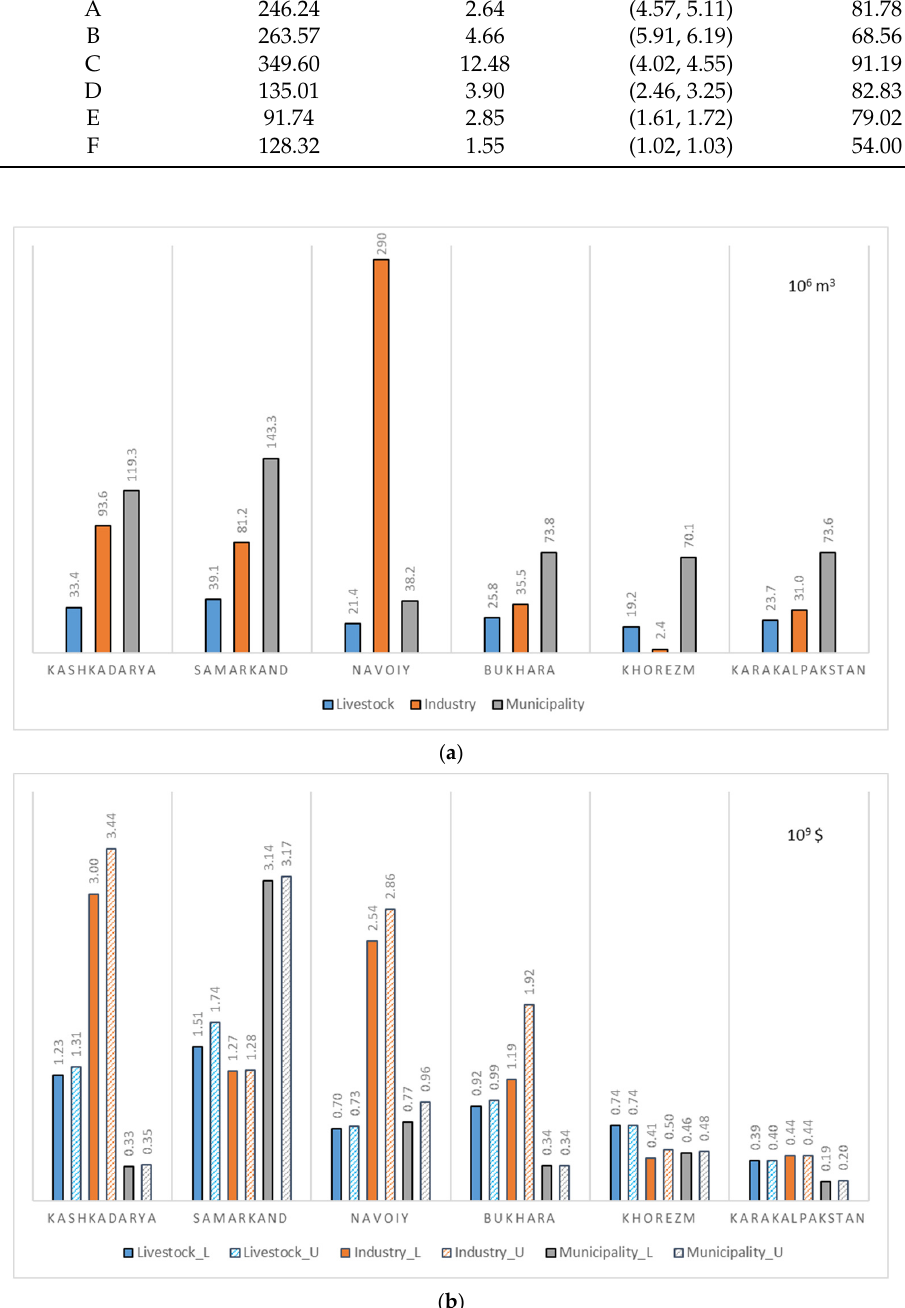
Figure 4. ( a ) Water allocation in different provinces for three sectors; ( b ) economic benefits in different provinces for three sectors. Table 13. Water allocation scheme in the sector of irrigation.